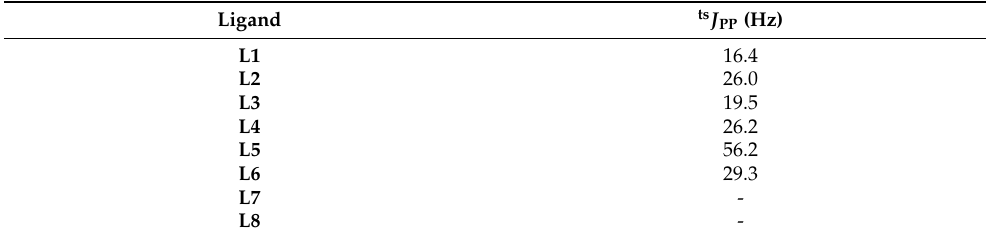
Table 1. Magnitude of the ts J PP coupling constants in L1 – L8 .